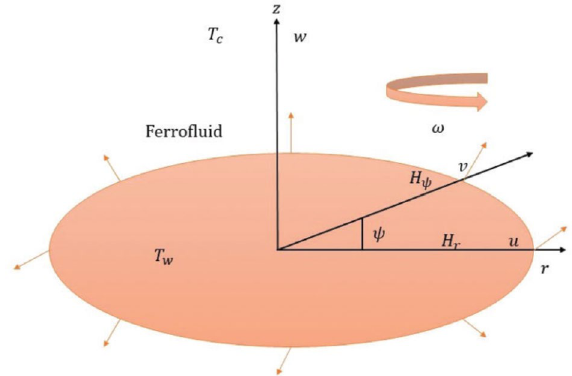
Figure 1. Flow across an extending disc is